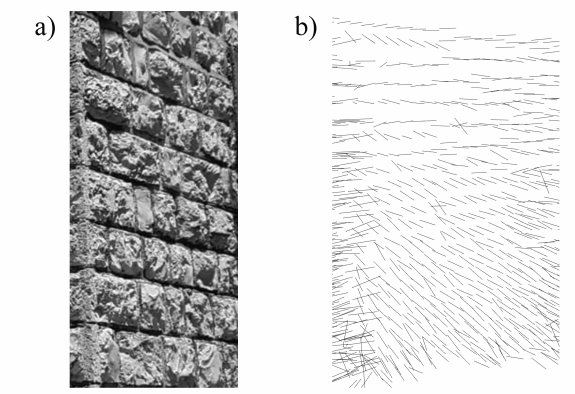
Figure 3: Textured wall (a) and its respective computed normal vectors